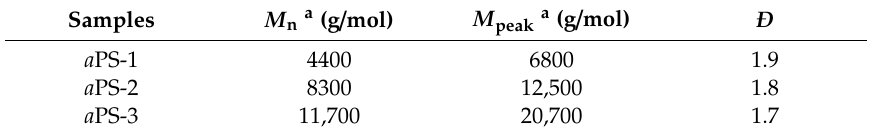
Figure 2. 1 H-NMR spectra of TBDB and methoxysilane-terminated a PSes ( a PS arms). Solvent (*): 1,1,2,2-tetrachloroethane- d 2 .